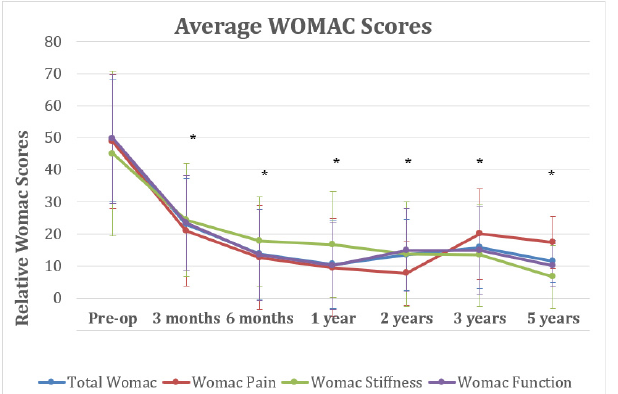
Figure 5. Average Western Ontario and Mc Master Index (WOMAC) for patients enrolled in the study, including the total score (blue), as well as the pain (red), stiffness (green), and function (blue) subscores over time. The graphs reports averages +/ − SD. Asterisks (*) indicate statistical significance for all WOMAC scores (total WOMAC, WOMAC pain, WOMAC Stiffness, WOMAC Function) at the respective timepoint compared with the pre-op control scores, as determined by Student’s t -test ( p < 0.05).